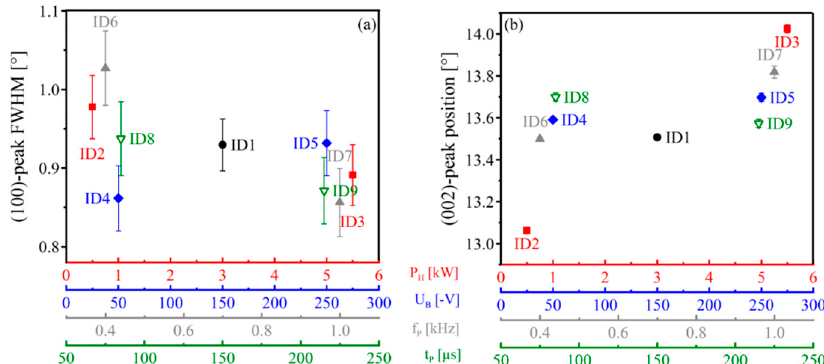
Figure 5. Dependence of the ( a ) (100)-XRD-peak full width at half maximum (FWHM) and ( b ) (002)-peak position on the heating power P H and bias-voltage U B , for f p = 0.7 kHz and t p = 150 µs, as well as the pulse frequency f p and pulse duration t p , for P H = 3 kW and U B = − 150 V. In ( b ) the absolute error does not exceed the symbol size.